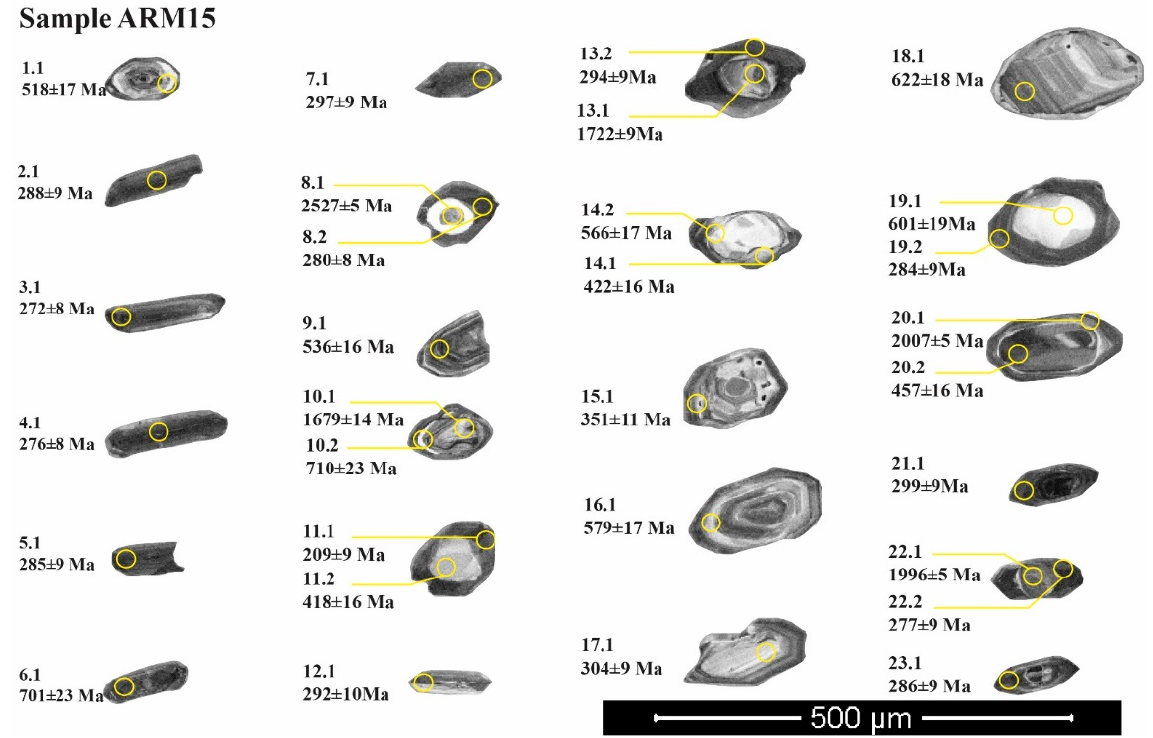
(ARM15) showing their internal texture, spots (yellow circles), and apparent 206 Pb/ 238 U ages in Ma